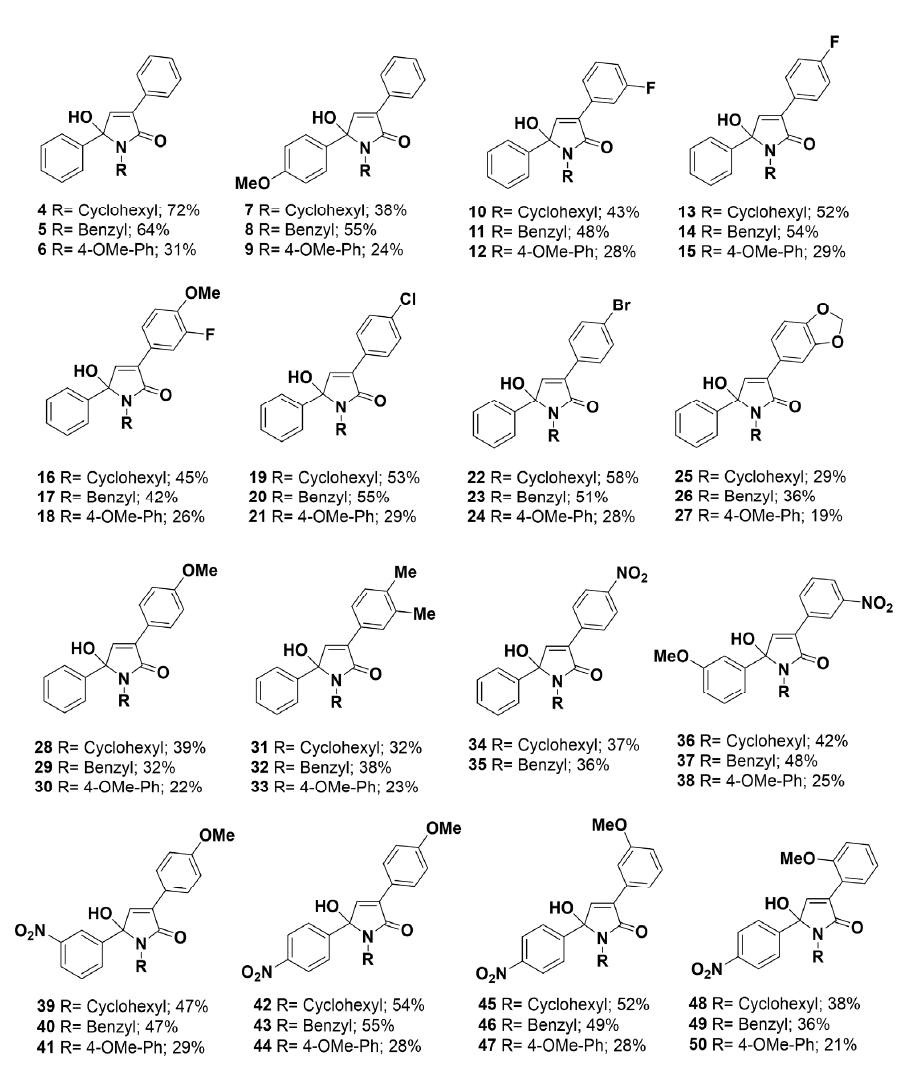
Figure 2. Structures and yields of 5-hydroxy-3,5-diaryl-1,5-dihydro-2 H -pyrrol-2-ones ( 4 – 50 ).